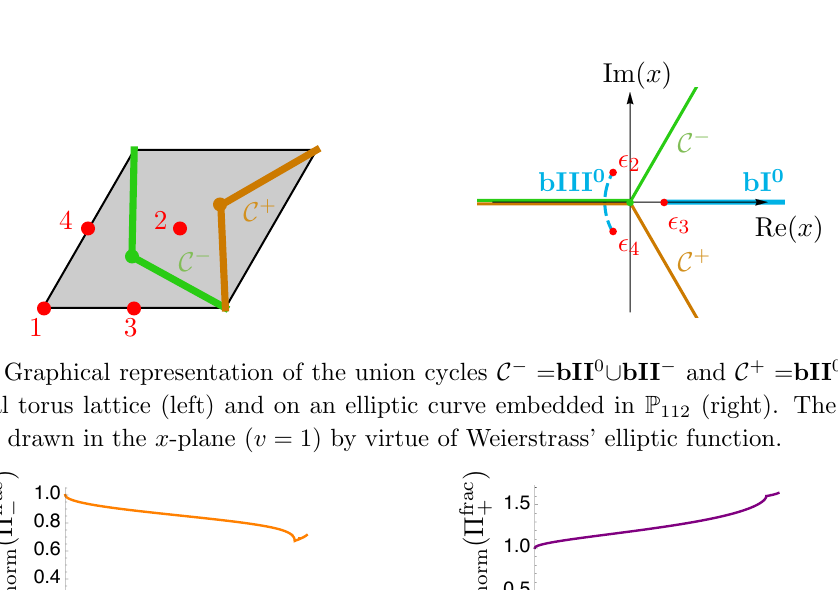
Figure 10 . Normalised volume of the fractional cycles (cid:5) frac deformation parameter " (1)